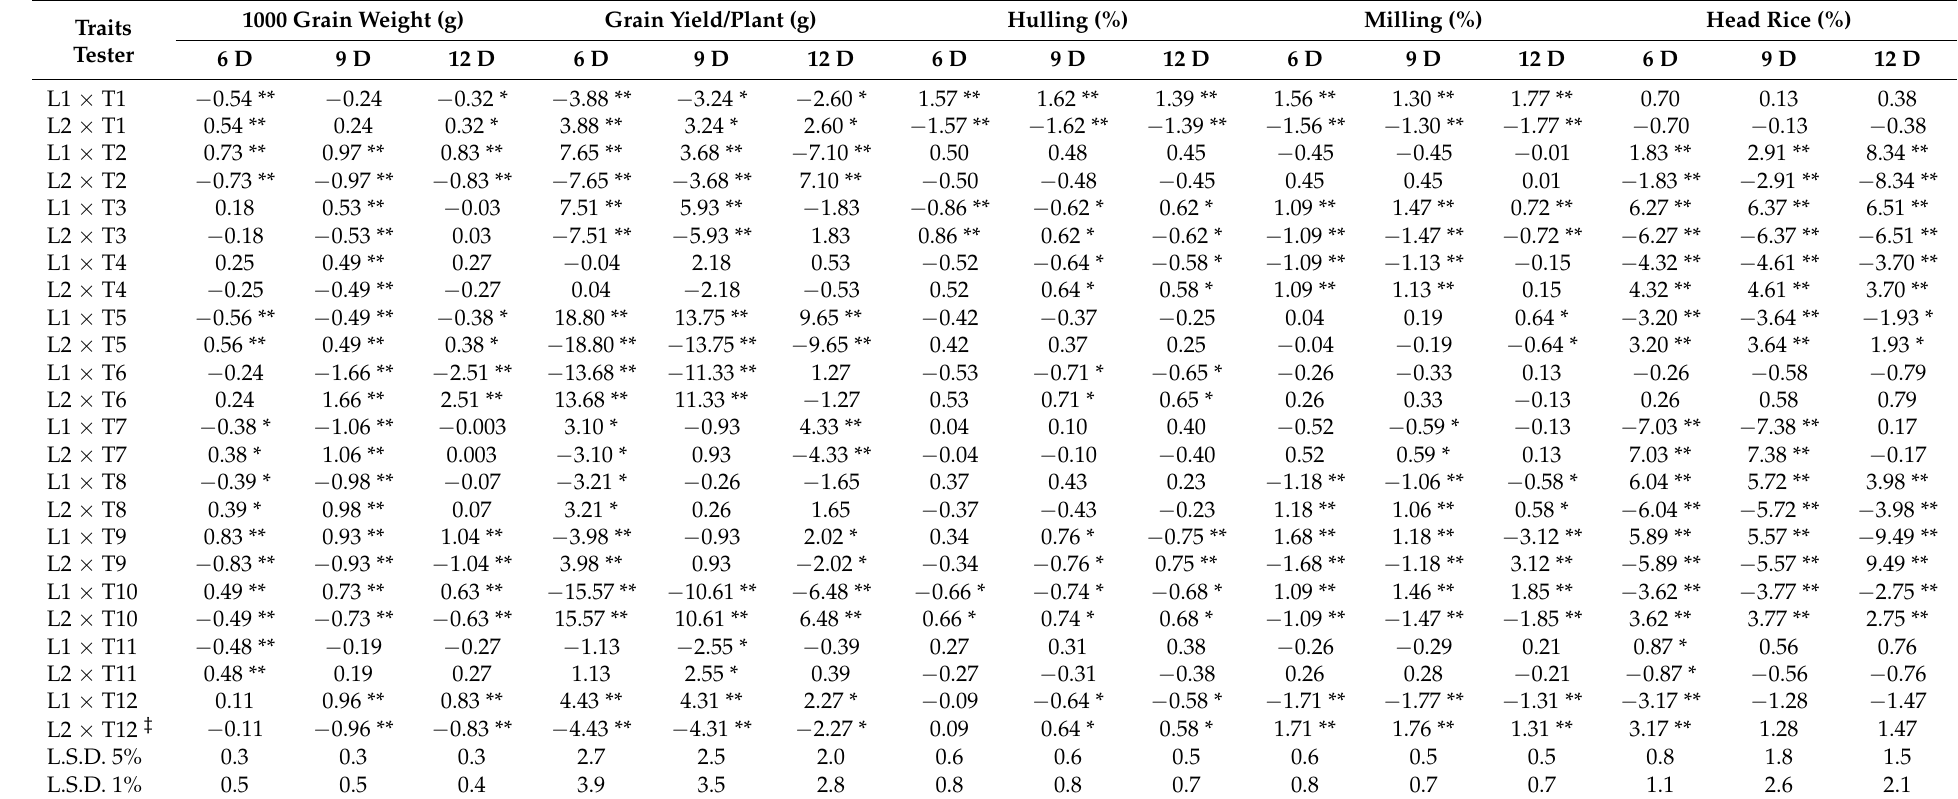
Table 10. Specific combining ability effects of the crosses for 1000 grain weight, grain yield/plant and grain quality